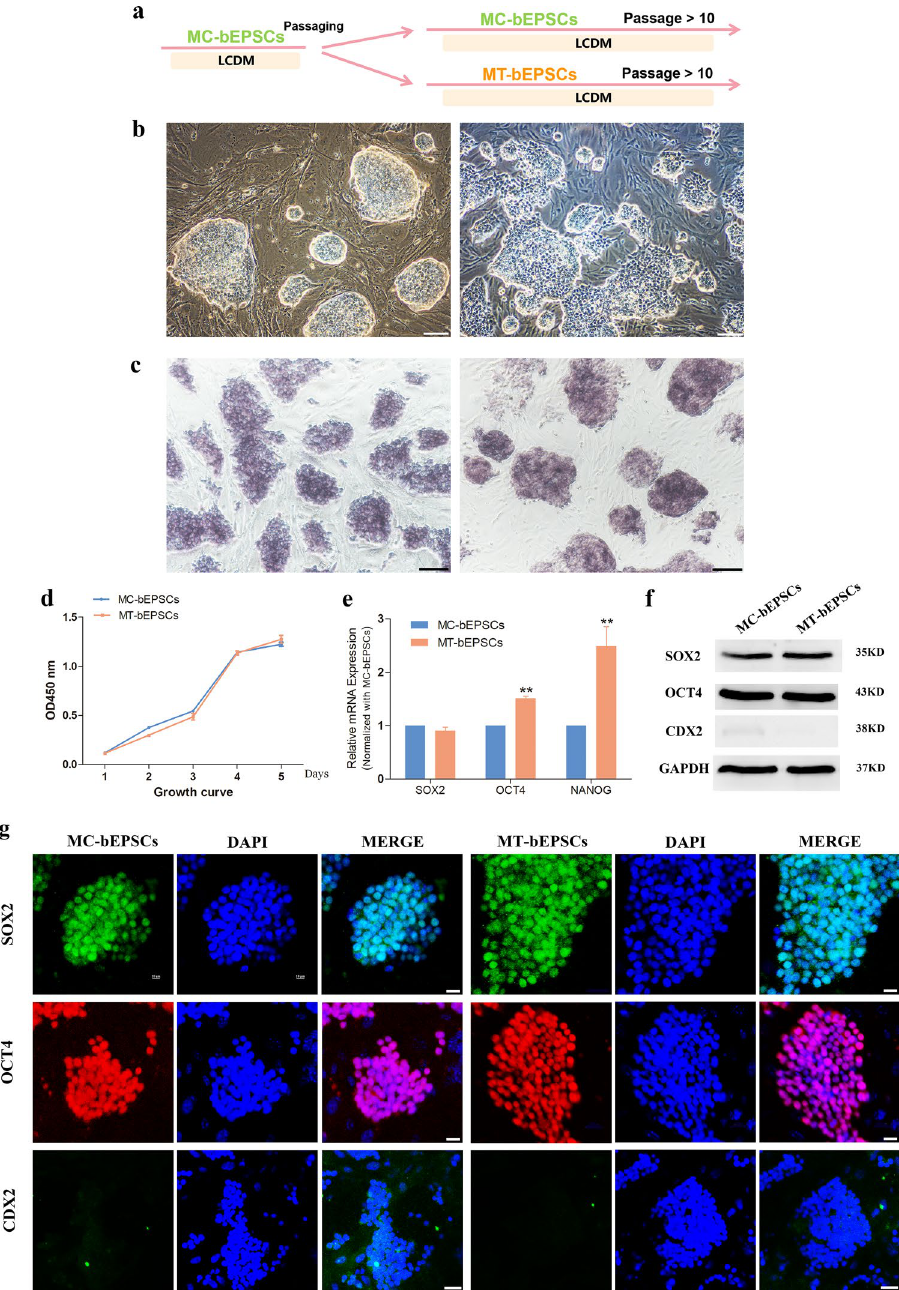
Figure 7. Effects of the methanol-fixed feeder layer on the bEPSCs. ( a ) The schematic diagram shows experimental strategy for analyzing bEPSCs grown on MT-MEFs and MC-MEFs. ( b ) The morphology of MC-bEPSCs and MT-bEPSCs. Bar = 100 μm. ( c ) AKP staining of MC-bEPSCs and MT-bEPSCs. Bar = 100 μm. ( d ) Growth curve of MC-bEPSCs and MT-bEPSCs. ( e ) RT-PCR analysis shows the expression of SOX2, OCT4 and NANOG in the MC-bEPSCs and MT-bEPSCs. ( f ) Western blotting analysis shows the expression levels of OCT4, SOX2, and CDX2 in the MC-bEPSCs and MT-bEPSCs. ( g ) Immunofluorescence staining assay results show the expression levels of SOX2, OCT4, and CDX2 in the MC-bEPSCs and MT-bEPSCs. Bar = 100